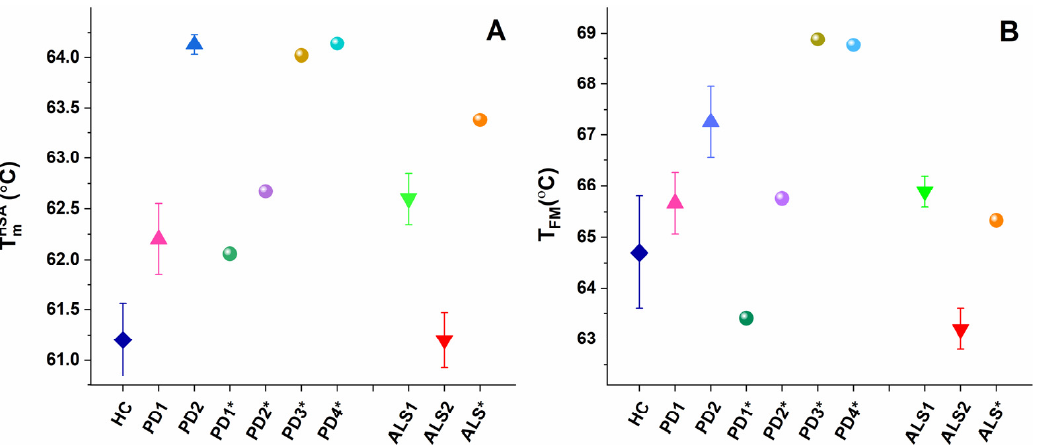
Figure 3. Temperature of albumin unfolding, T mHSA ( A ), and the weighted average center of the thermogram, T FM ( B ), for PD and ALS sets (mean and SD) and for non-stratified PD1*–PD4* and ALS* cases.